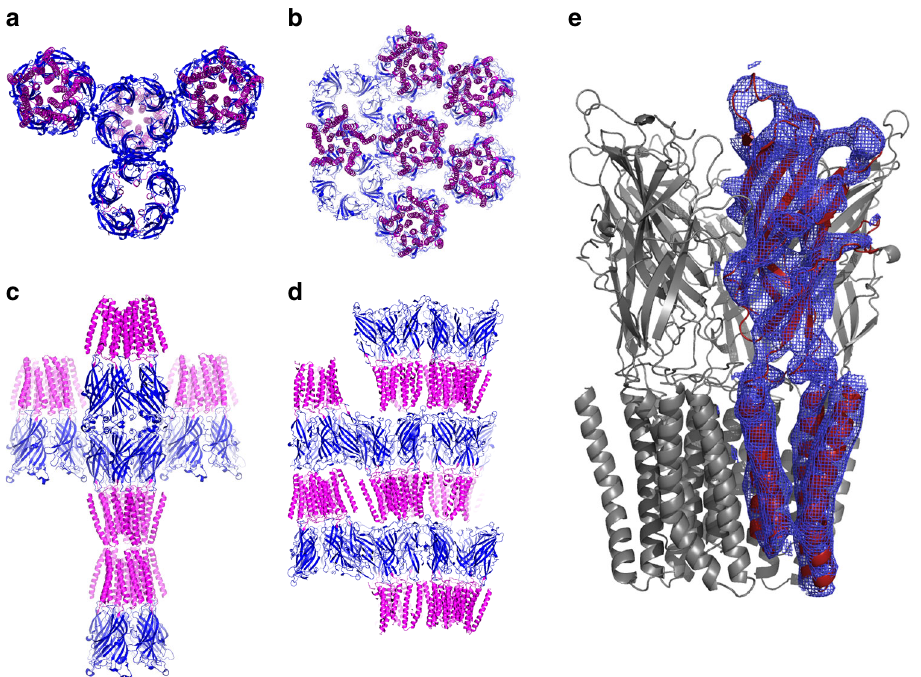
Fig. 5 GLIC protein structure obtained from in meso grown crystals. a – d Crystal packing of the GLIC protein in crystals grown from vapor diffusion, in the C2 space group ( a , c ), compared with the packing obtained by in meso crystallization, in space group C222 1 ( b , d ). e Structure of the GLIC protein (PDB ID 6F7A) from the in meso grown crystals. The electron density is contoured at 1 σ , and shown representatively only around one of the units of the pentamer for clarity state as opposed to the more conventional open state found in Table 1 Data collection and re fi nement statistics for the in loose crystals obtained by vapor diffusion. meso GLIC These results showcase the possibility of expanding the reach of the in meso crystallization method to previously unreachable proteins and to design protein crystals into different space groups, packing ef fi ciency, and activation states inaccessible via other crystallization methods, providing powerful tools of signi fi cance to membrane protein structural biology.